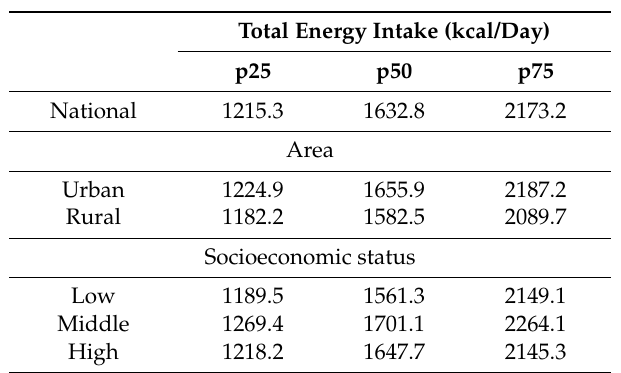
Table 3. Total energy intake according to socio-demographic variables